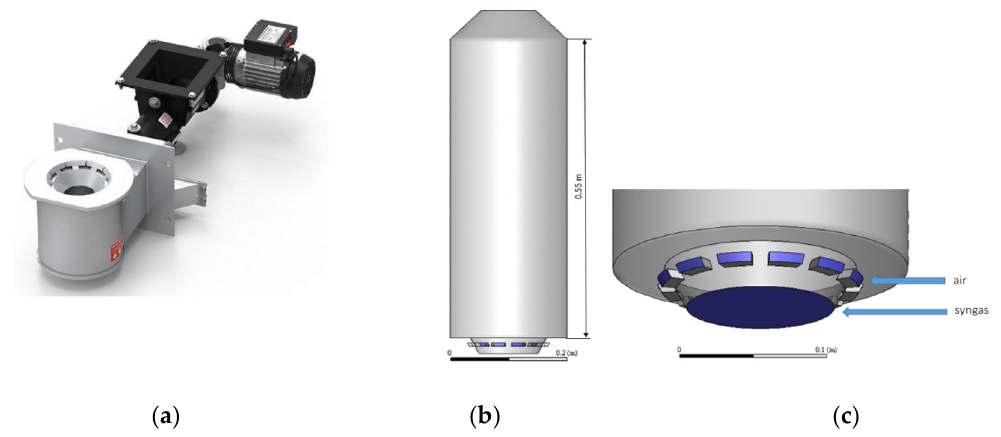
Figure 2. Retort burner for gasification of pellets: ( a ) view of the burner structure, ( b ) burner model in a cylindrical chamber, ( c ) burner model.